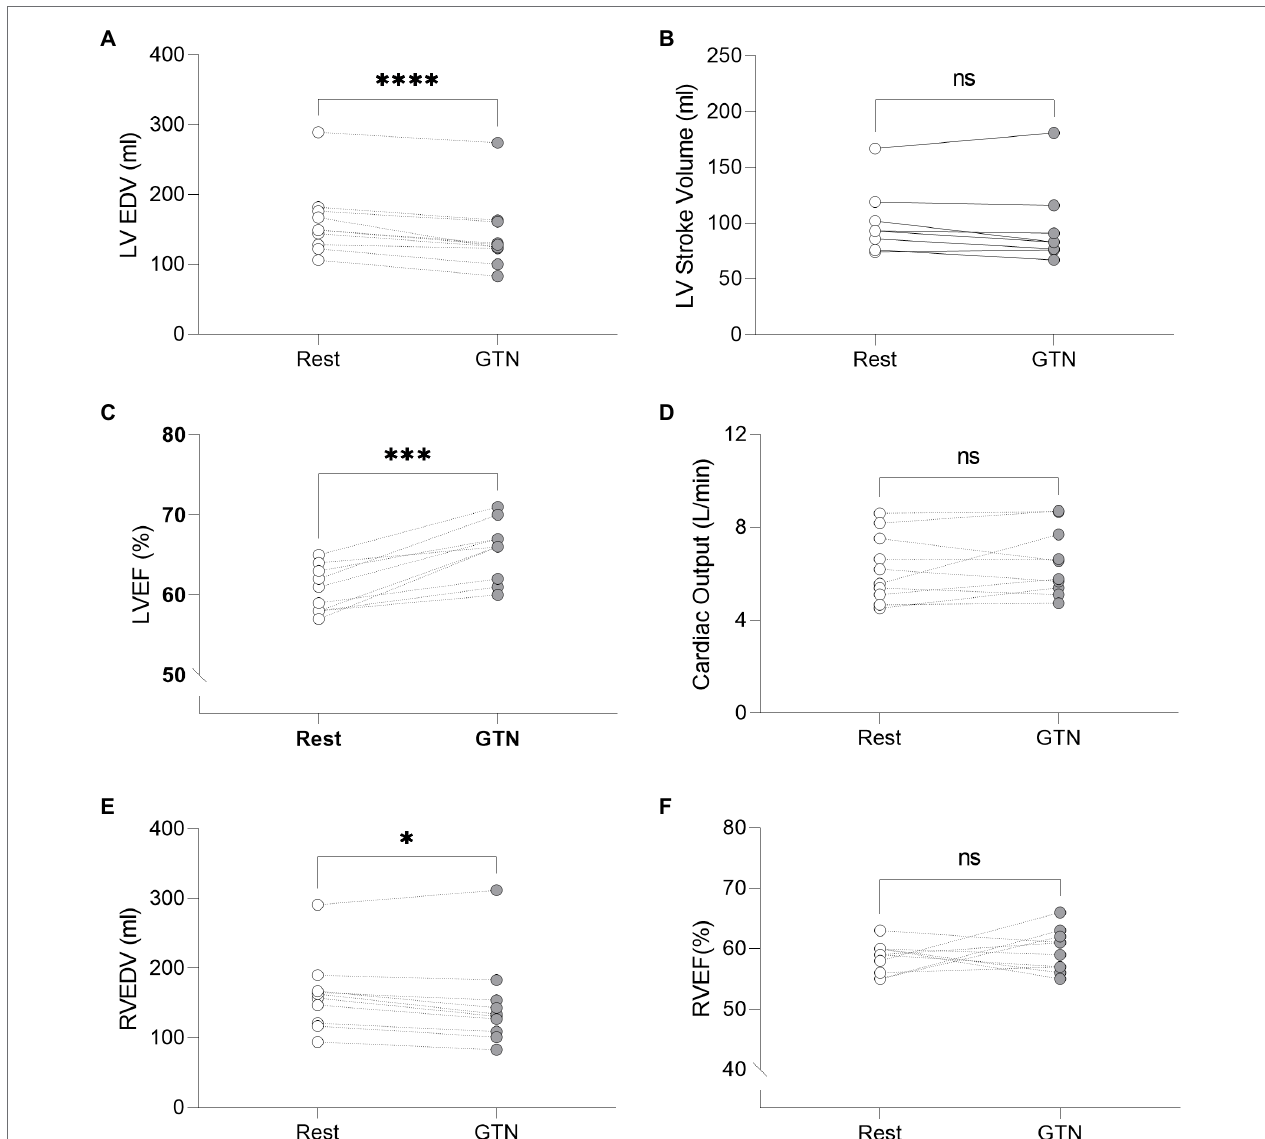
FIGURE 1 | Left and Right ventricular measurements at rest and during GTN infusion. (A) Left ventricular end diastolic volume, (B) Left ventricular stroke volume, (C) Left ventricular ejection fraction, (D) Cardiac output, (E) Right ventricular end diastolic volume, and (F) Right ventricular ejection fraction. * p < 0.05, *** p < 0.001, and **** p < 0.0001.